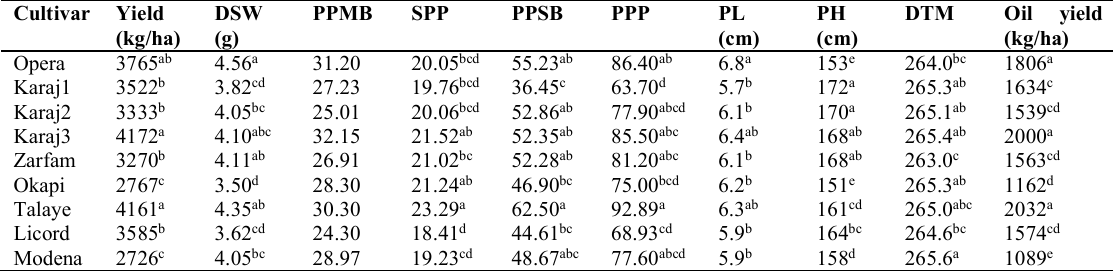
Similar letters in each column show that there is not significant differences between cultivar at P=0.05